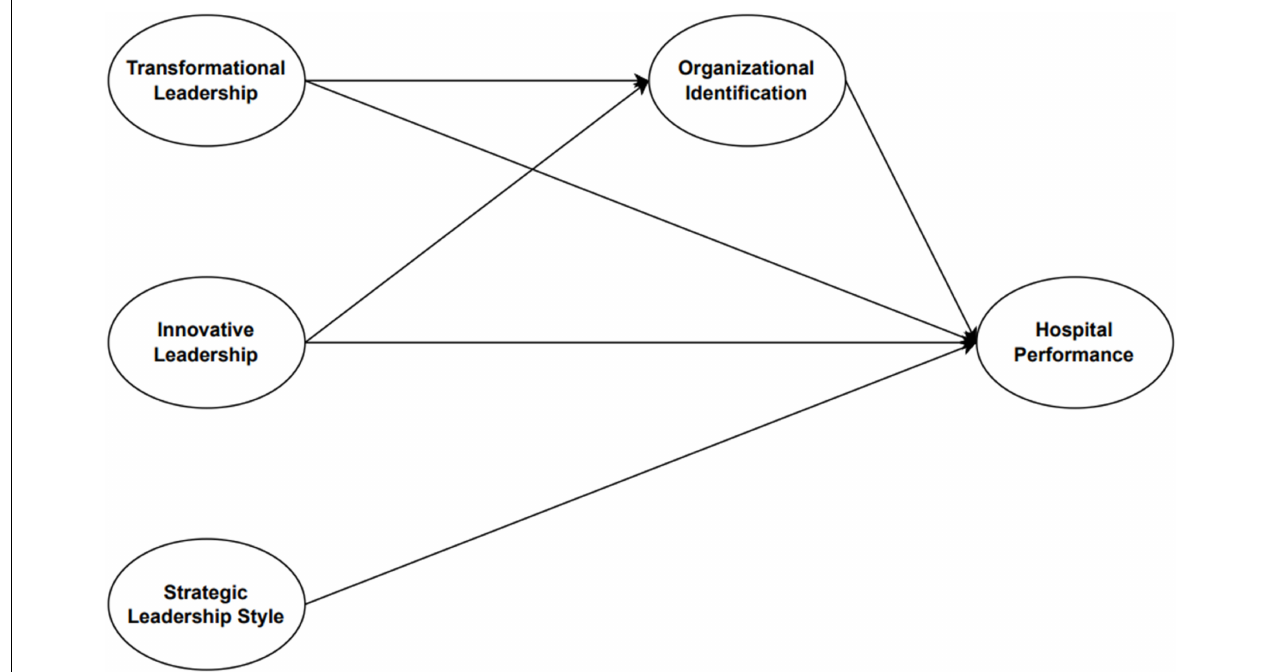
FIGURE 2 | Research